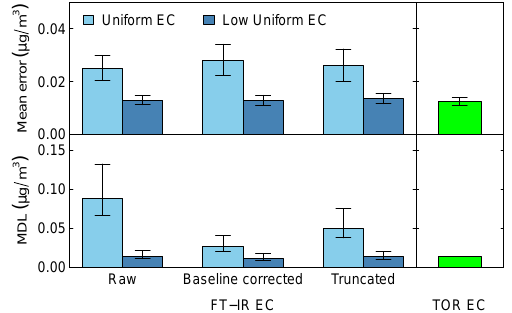
Figure 2. Mean error of a Low EC test set (EC < 2.4µg) and MDL from the Uniform EC and Low Uniform EC calibrations. The same Low EC test set is predicted by the Uniform and Low Uniform cal- ibrations. The mean error of collocated EC samples less than 2.4µg and the reported EC MDL for the TOR method are shown for com-